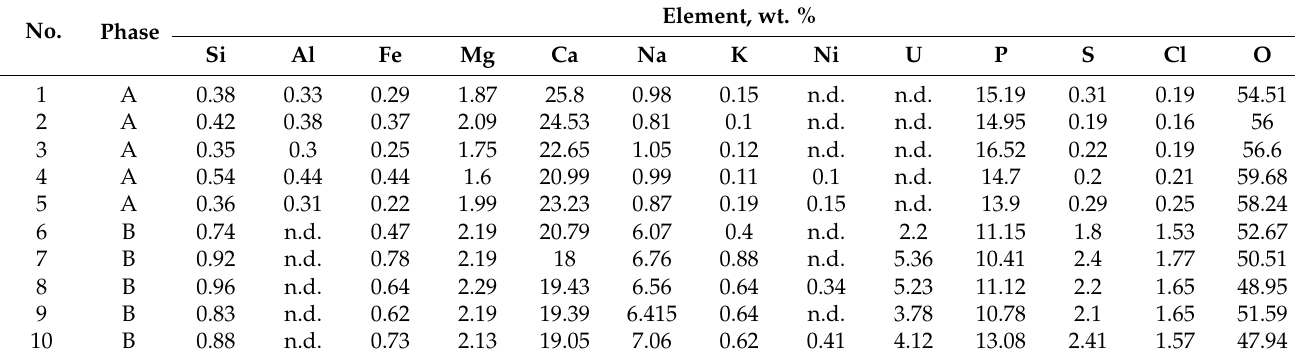
Figure 6. First (bright) phase ( A ) and second (dark) phase ( B ) of the precipitate (see Table 8 for the composition). Table 8. Elemental composition of the precipitate phases after whey